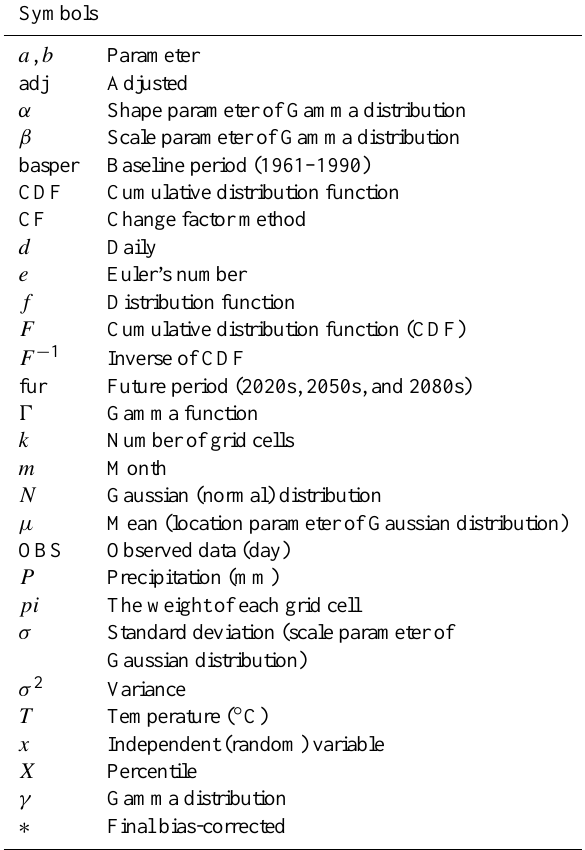
Table 1. Symbols, variables, and